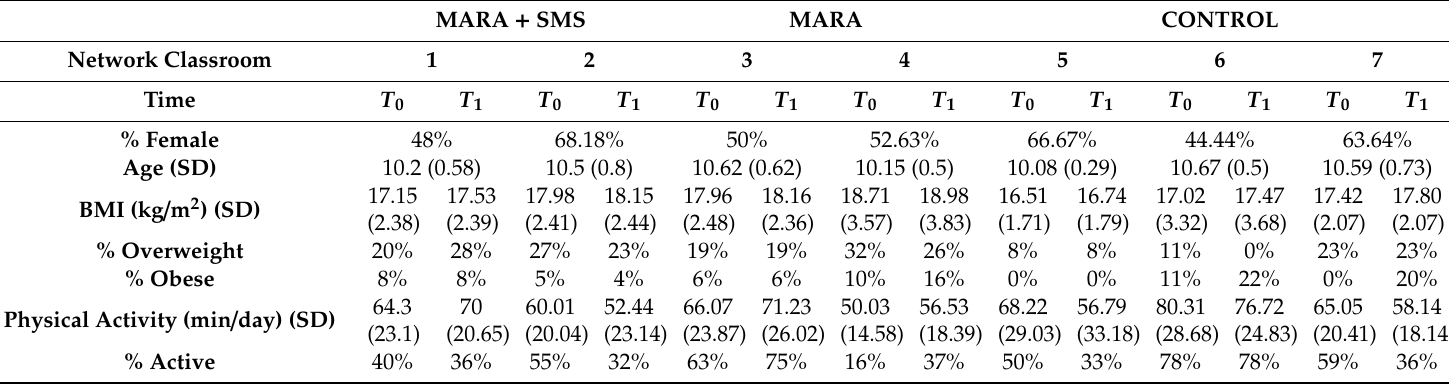
Table A1. Descriptive measures of age, gender, body mass index (BMI), and physical activity for two time-points in the three di ff erent schools of the study. MARA + SMS MARA CONTROL